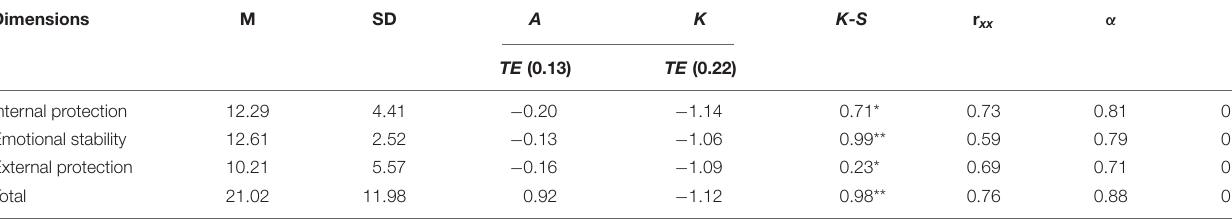
TABLE 4 | Internal consistency (alpha, omega, and two-halves) for SRSA-18 and by dimensions. Dimensions M SD A K